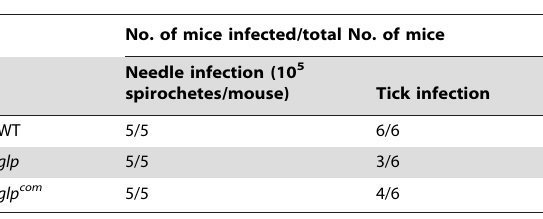
Table 5. Mouse infectivity of the glp mutant.